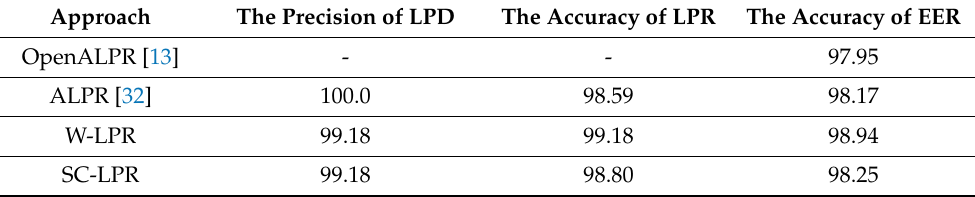
Table 5. The performance comparison of different methods that were implemented in this study, which include LPD, LPR, and